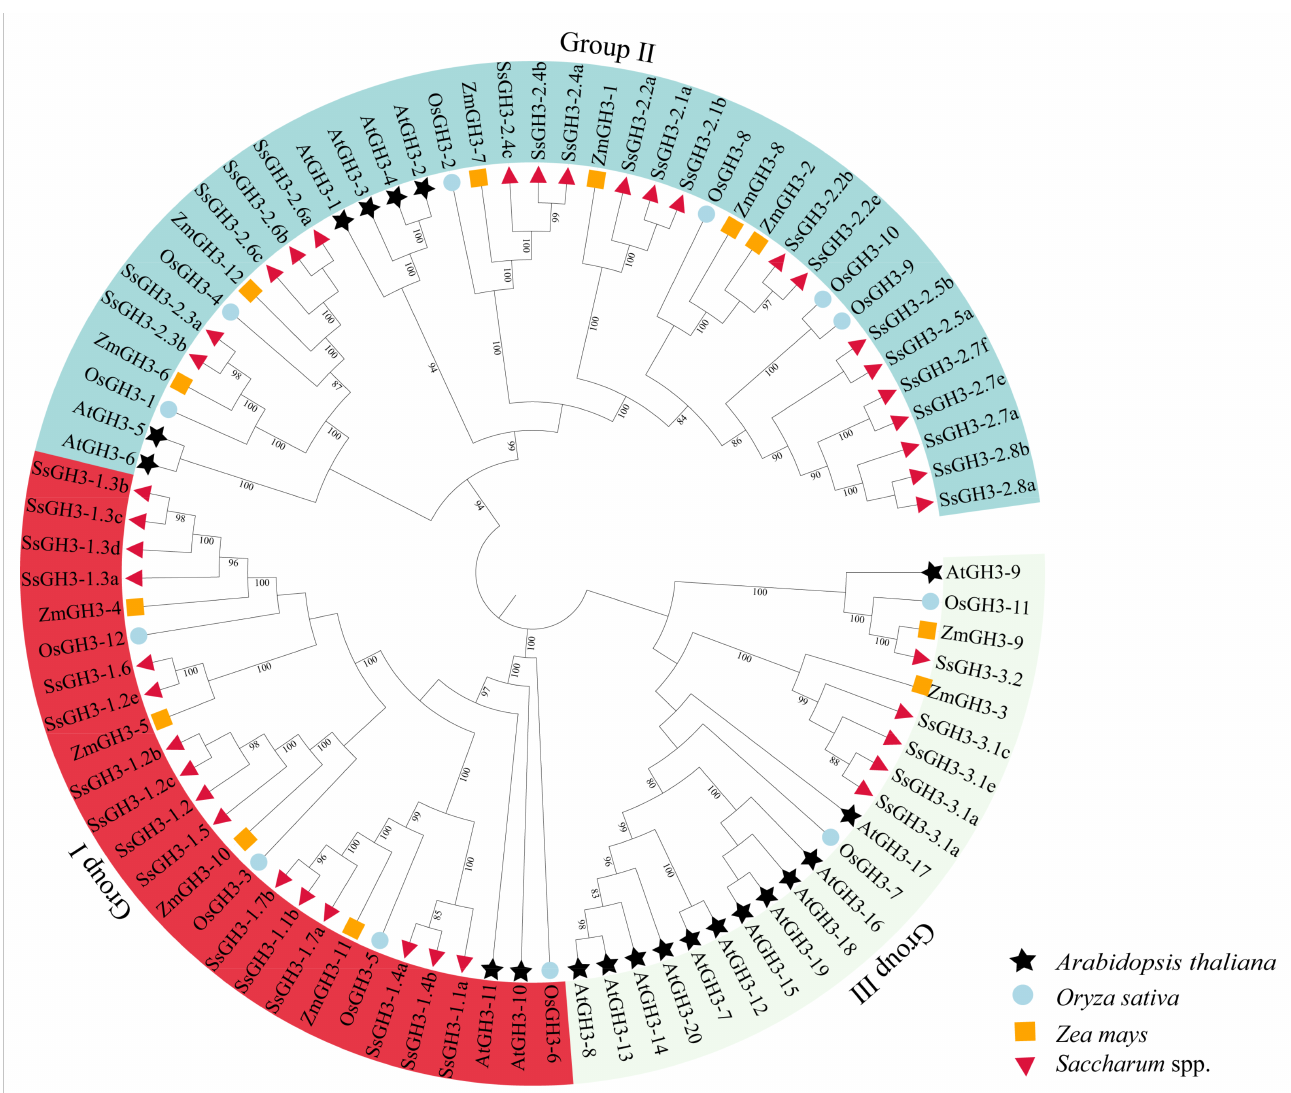
Figure 1. Phylogenetic analysis of the GH3 homolog proteins from 4 plant species. MEGA X with the maximum likelihood (ML) method was used to create the phylogenetic tree. GH3-related proteins from four species: Saccharum spontaneum (Ss), Oryza sativa (Os), Zea mays (Zm), and Arabidopsis thaliana (At). All the GenBank accession numbers are listed in Table S3 in the Supplementary Materials. Three major clades were distinguished with three colors, and GH3 proteins from different plant species were decorated with different colors and